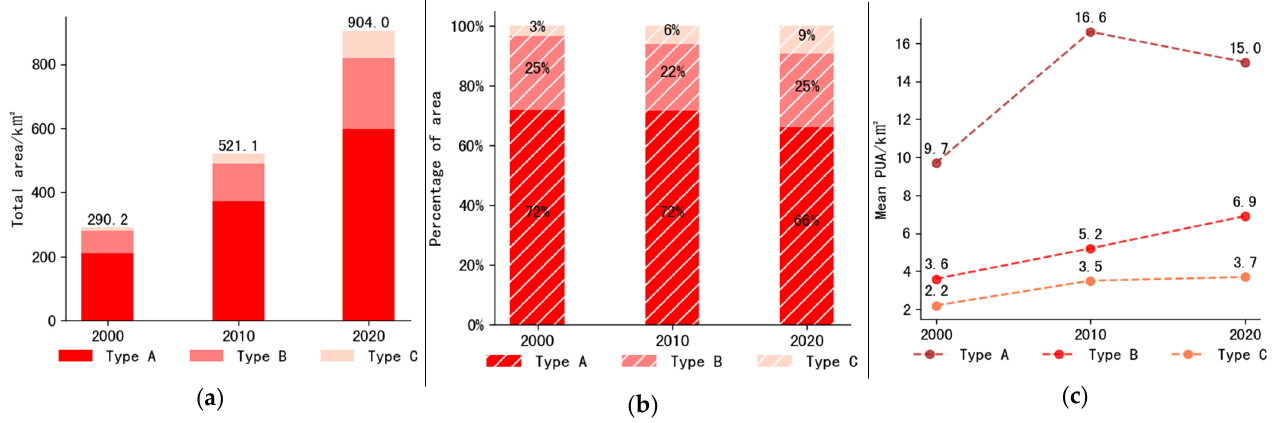
Figure 10. Visualization of Table 2: ( a ) Total area of three types in 2000, 2010, and 2020; ( b ) Area percentage of three types in 2000, 2010, and 2020; ( c ) Mean area of three types in 2000, 2010, and 2020.